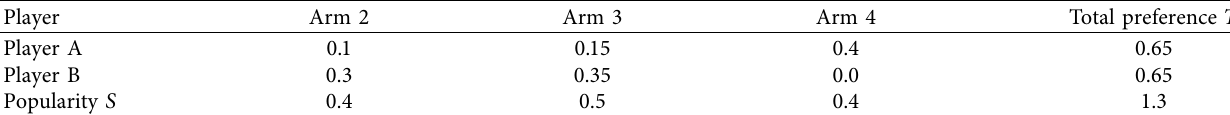
Table 7: Preference profle for the remaining part in [Case 2].